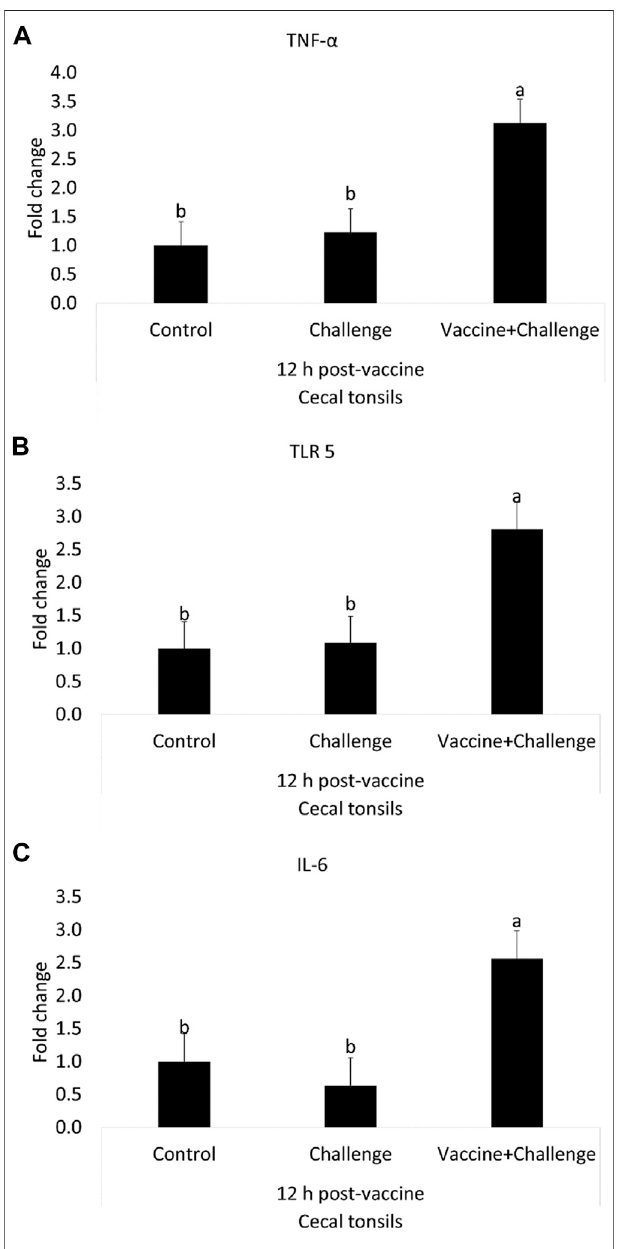
FIGURE5| TheEffectsof Salmonella CNP VaccineonGeneExpression in the Cecal Tonsils of Vaccinated Birds at 12 h post-challenge. At d1 of age birds were allocated into treatment groups: 1) Control; 2) Challenge; or 3) Vaccine + Challenge. At d1 and d7 of age birds in the negative and positive control groups were mock vaccinated with PBS and birds in the treatmentgroupwerevaccinatedwithCNP.Atd14ofagebirdsinthenegative controlgroupweregivenamockchallengeof0.5 mlPBS/birdandbirdsinthe positive control and the treatment group were orally challenged with 1 × 10 7 CFU/bird of S . Enteritidis. Cecal tonsils were collected from one bird/pen (n = 6) at 12 h post-challenge. Data represented as fold change compared to control. (A) TNF- α mRNA; (B) IL-17mRNA; (C) IL-6mRNA.Bars(+SE)withno common superscript differ ( p < 0.05).